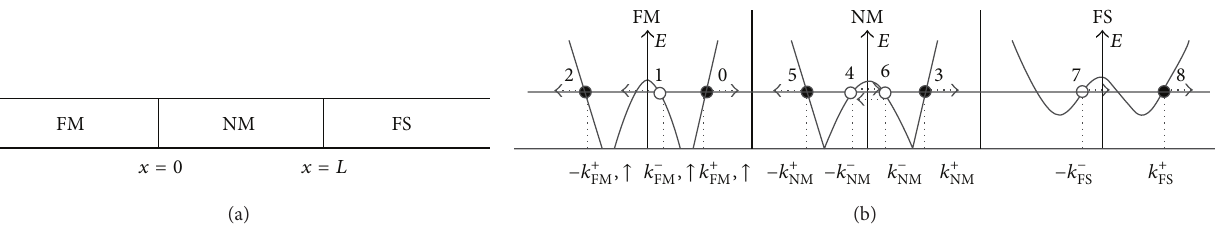
Figure 1: (a) Schematic diagram of a FM/NM/FS double junctions. (b) Schematic diagram of energy versus wave vector of a FM/NM/FS double junctions for a spin-up incident